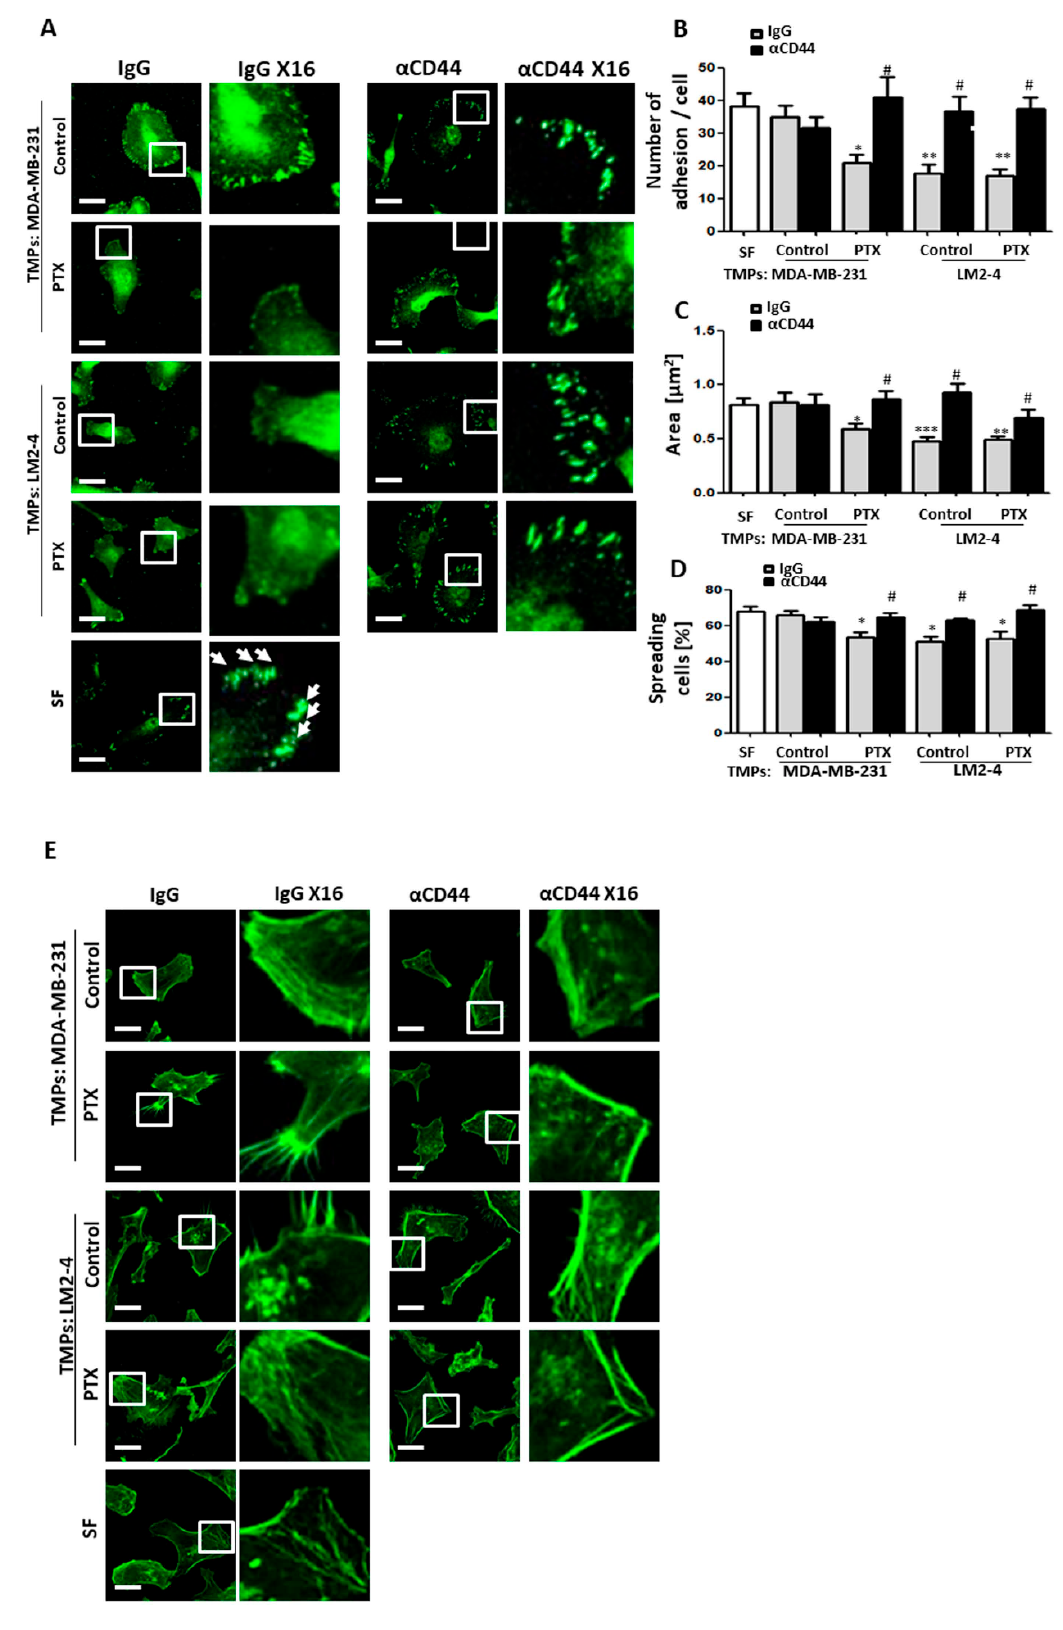
Figure 6. TMPs expressing CD44 decrease tumor cell adhesion and promote organized actin filament structure. TMPs from MDA-MB-231 or LM2-4 cells which had been exposed to paclitaxel (PTX) or vehicle control were incubated with anti-CD44 (5 µg/mL) or control IgG and subsequently cultured with MDA-MB-231 cells. As a control, MDA-MB-231 cells were cultured alone in serum-free